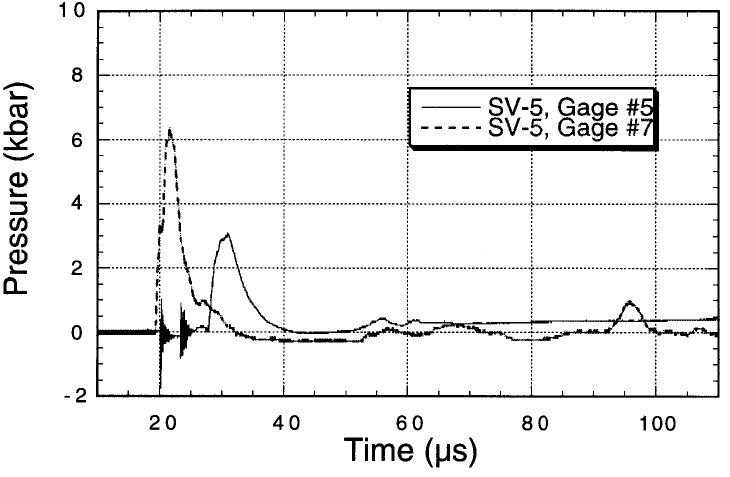
Fig. 2. Pressure from tourmaline gages at the wall/water interface in Shot